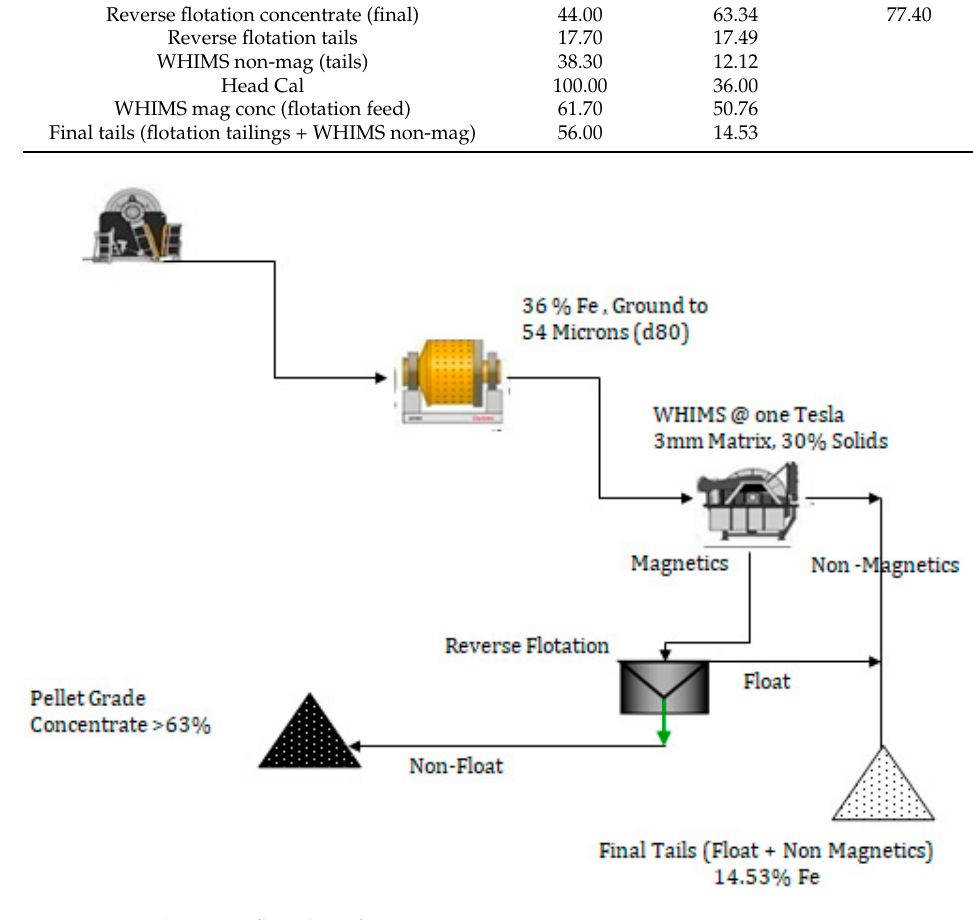
Table 11. The characteristics of concentrate of the final process.